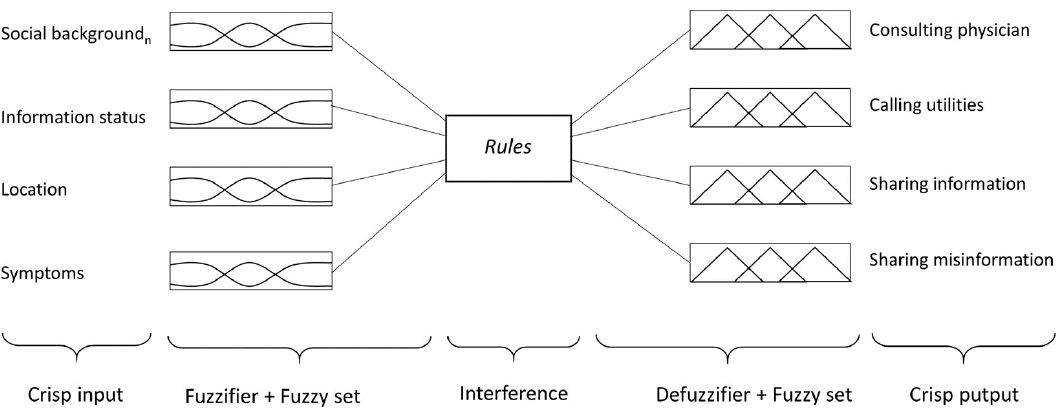
Figure 3. Fuzzy logic system to determine consumer agents’ actions.